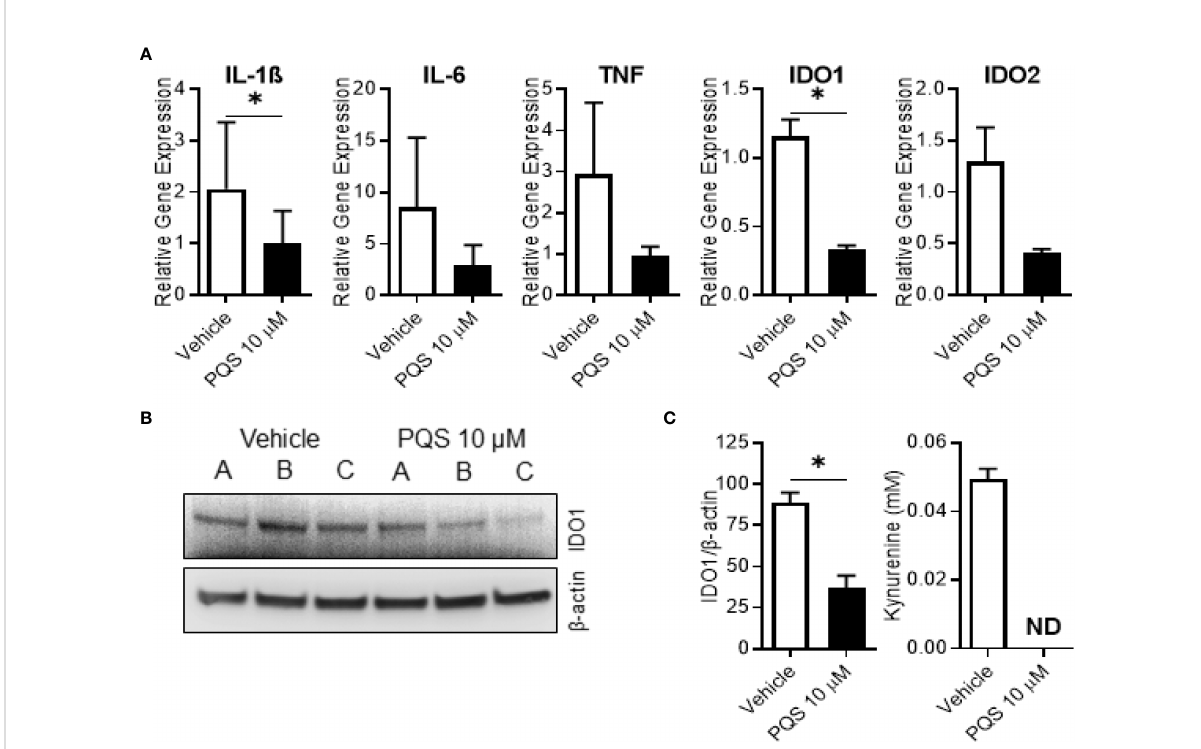
FIGURE 6 PQS inhibits IDO1 expression in human M1 macrophages. Monocyte-derived macrophages were polarised to an M1 phenotype overnight in the presence or absence of PQS (10µM) to measure gene expression, IDO1 protein expression and IDO1 activity. (A) Gene expression of IL1 b , IL6, TNF, IDO1 and IDO2; n=3 donors, *p<0.05. (B) Western blots of IDO1 and b -actin for 3 independent donors A, B and C. (C) (left) -quanti fi cation of (B) ; n=3 donors, *p<0.05; (right) - measurement of kynurenine in the culture medium (ND, not detected); n=3